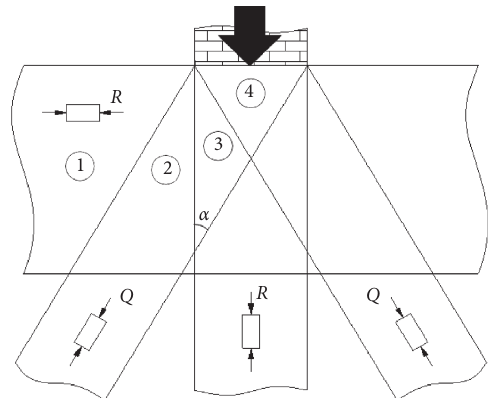
Figure 4: The stress field constructed by 3 stress columns.